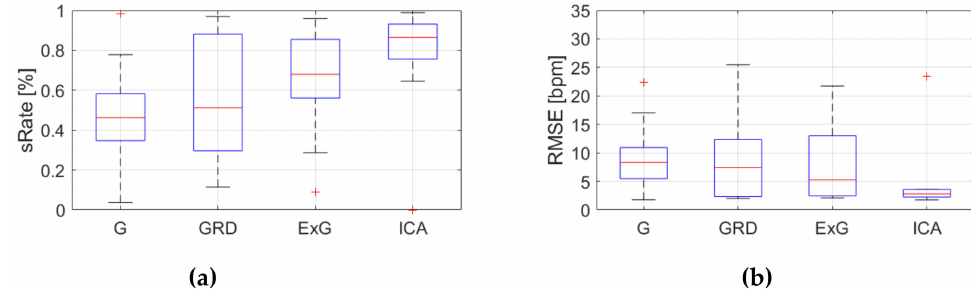
Figure 12. Comparison of signal extraction methods, algorithm No.1 (PSD), part 6: ( a ) box plots for sRate ; ( b ) box plots for RMSE . Blue lines—IQR range, red line—median value.